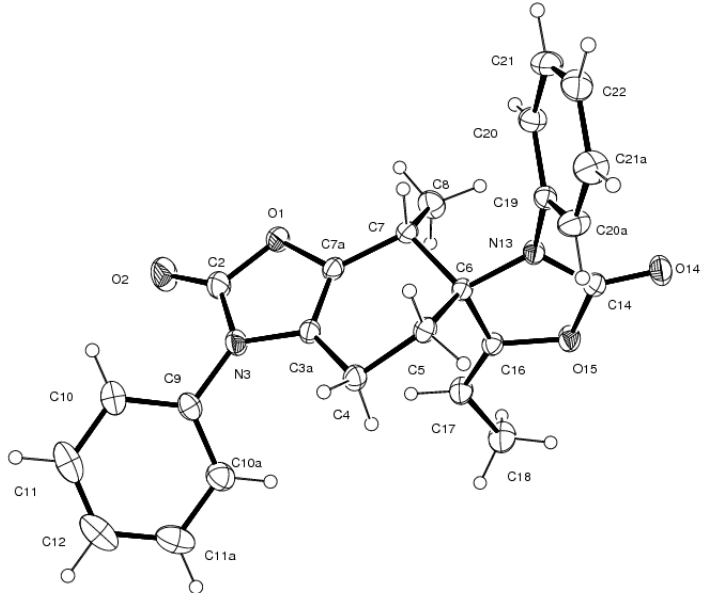
Figure 5. Molecular structure of 19 with thermal ellipsoids at the 30% probability